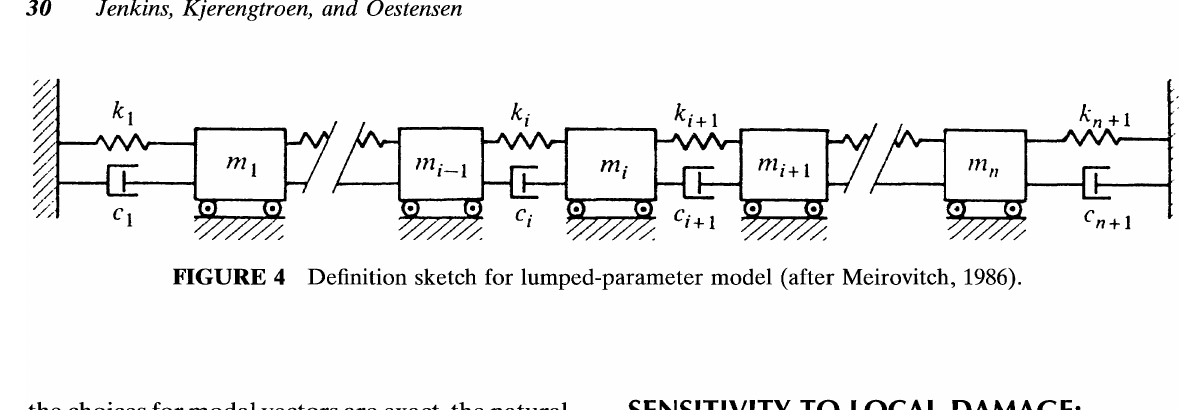
FIGURE 4 Definition sketch for lumped-parameter model (after Meirovitch,